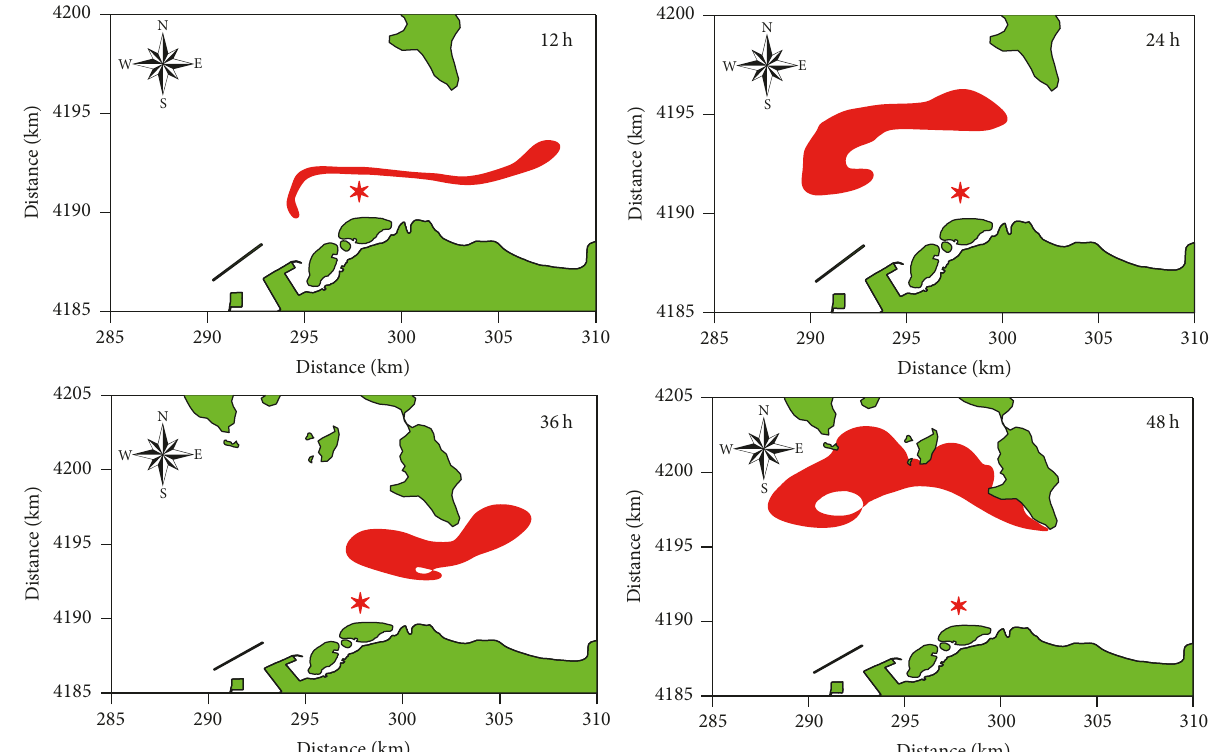
Figure 19: Transport processes of continuous oil spills (red area) from the eastern portion of the channel (red star symbol for the eastern spill location) under the influence of south winds.